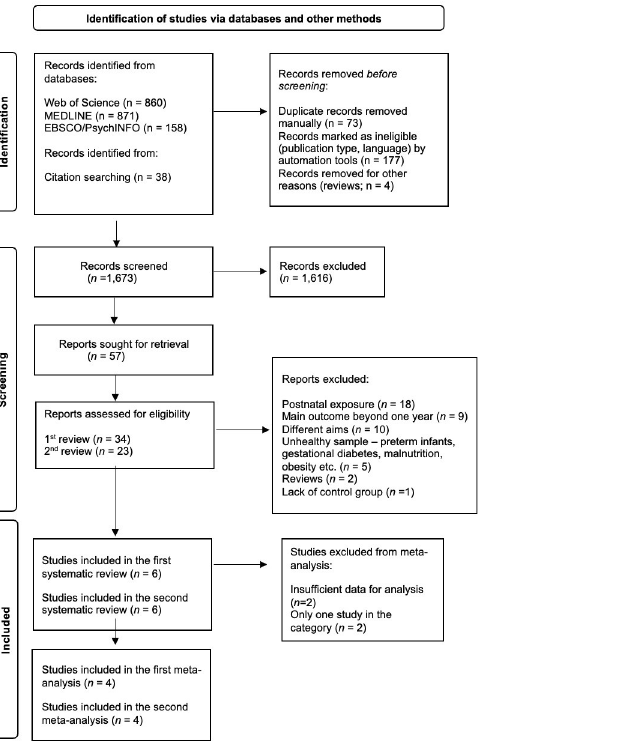
Fig 1. Flow diagram of